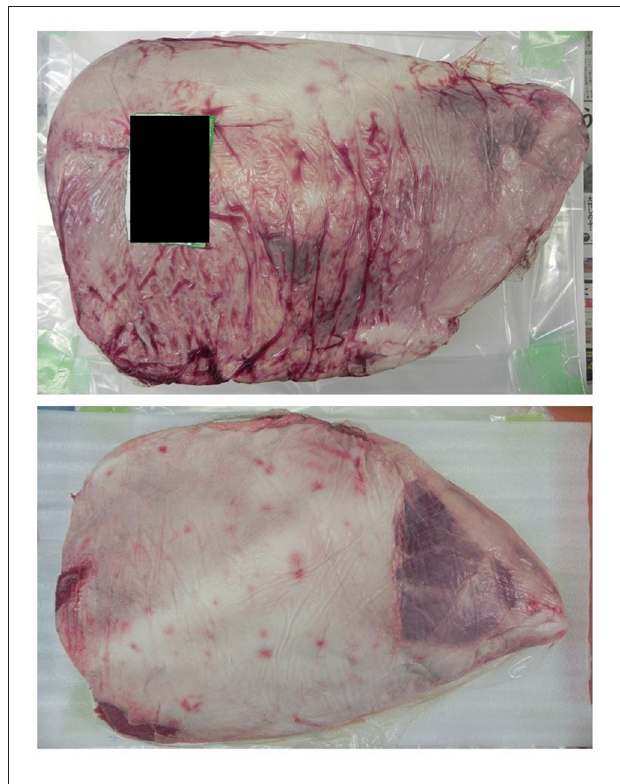
FIGURE 1 | The type of beef (beef leg) used in this research.